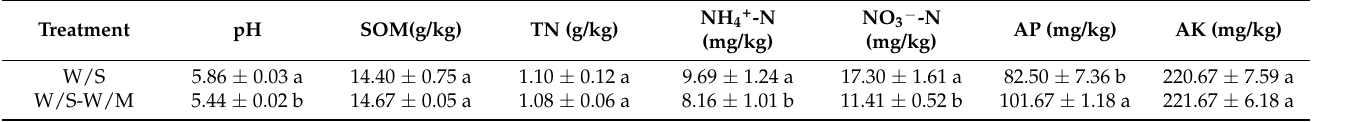
Table 1. Effects of different cropping systems on soil chemical